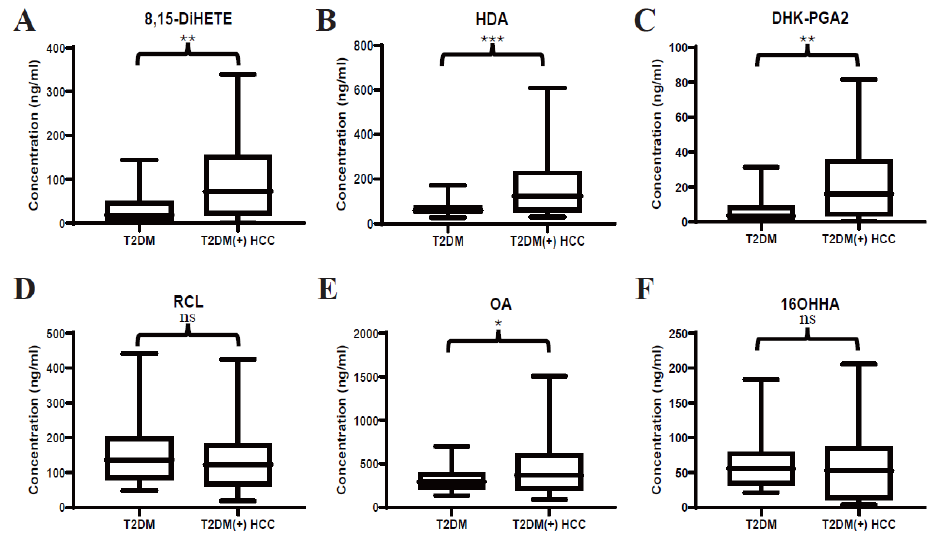
Figure 2. Expression profiles of several dysregulated serum lipids in the discovery set. ( A – F ) represent the levels of serum 8,15-DiHETE, HDA, DHK-PGA2, RCL, OA and 16OHHA in the discovery set, respectively. Student’s t test or Mann-Whitney U test was applied. T2DM, type 2 diabetes mellitus; HCC, hepatocellular cancer. *** p value < 0.001; ** p value < 0.01; * p value < 0.05; ns, not significant. Table 3. List of differential lipids identified in the untargeted metabolomic analyses.